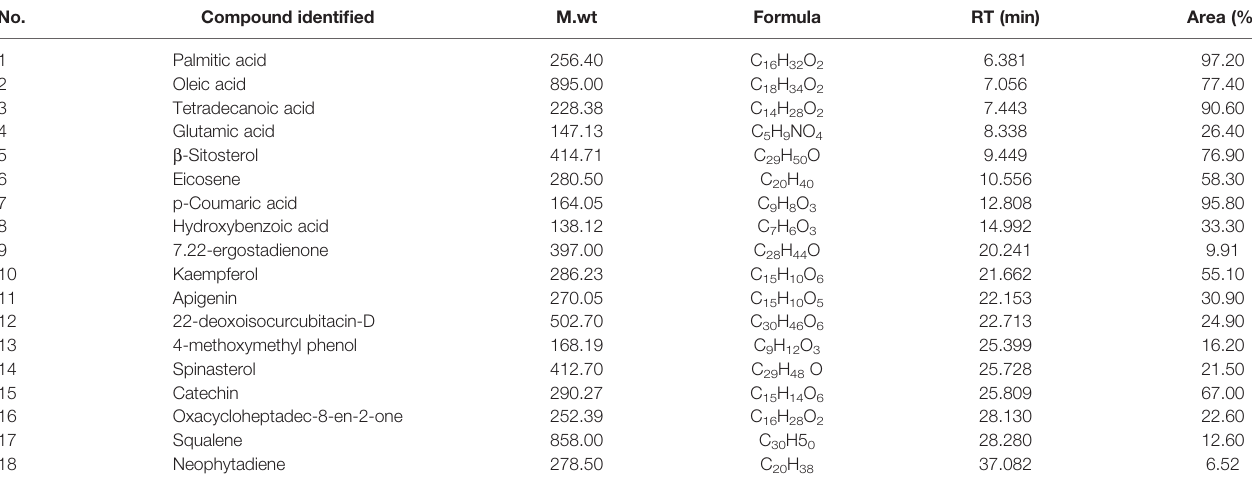
TABLE 2 | Identi fi ed components by GC-MS of L. siceraria seed extract. No. Compound identi fi